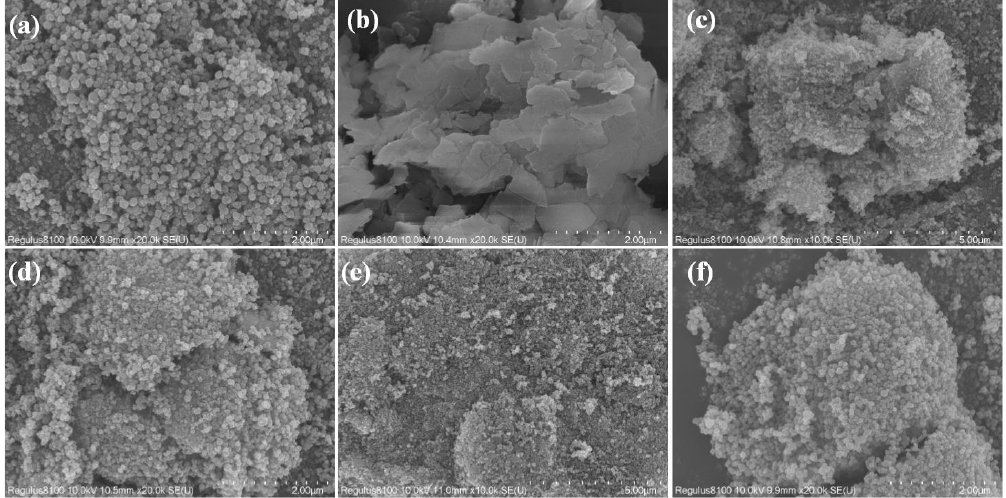
Figure 1. SEM of ( a ) Fe 3 O 4 at 20k times, ( b ) MoS 2 at 20k times, ( c ) Fe-Mo-1 at 10k times, ( d ) Fe-Mo-1 at 20k times, ( e ) Fe-Mo-2 at 10k times and ( f ) Fe-Mo-2 at 20k times.